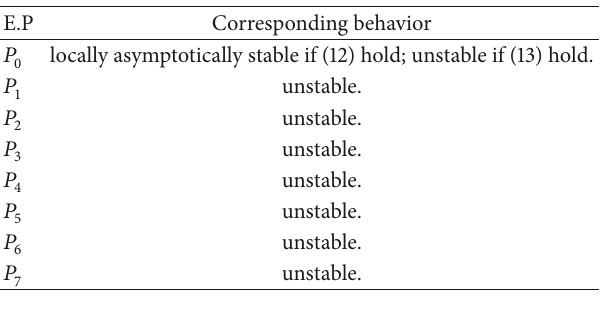
Table 1: Number of Equilibria along their qualitative behavior of